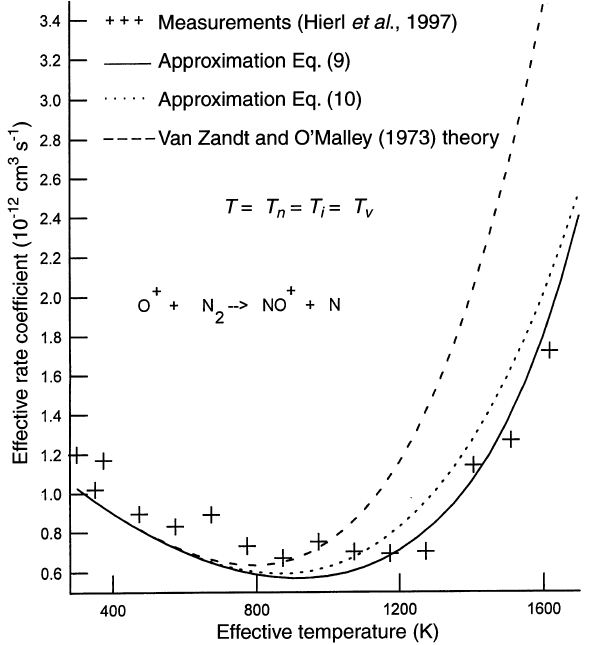
Fig. 1. E(cid:128)ective rate coe(cid:129)cients for the reaction of O (cid:135) (cid:133) 4 S (cid:134) with N 2 as a function of a temperature from the measurements given by Hierl et al. (1997) ( crosses ), the Van Zandt and O’Malley (1973) theory ( dashed line ) of K 1 v (cid:133) v > 0 (cid:134) , the assumptions in Eqs. (9) ( solid line ) and (10) ( dotted line ) for T (cid:136) T v (cid:136) T n (cid:136) T i